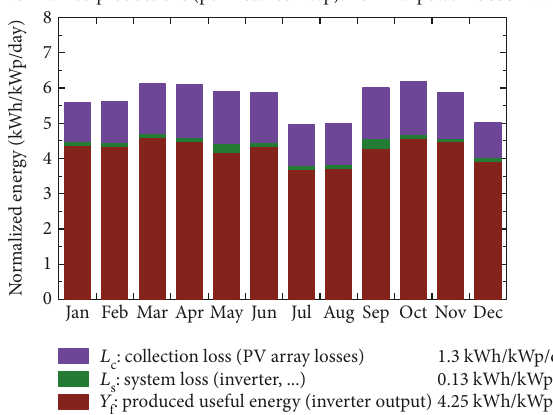
Figure 7: Monthly graph of performance ratio of the plant.